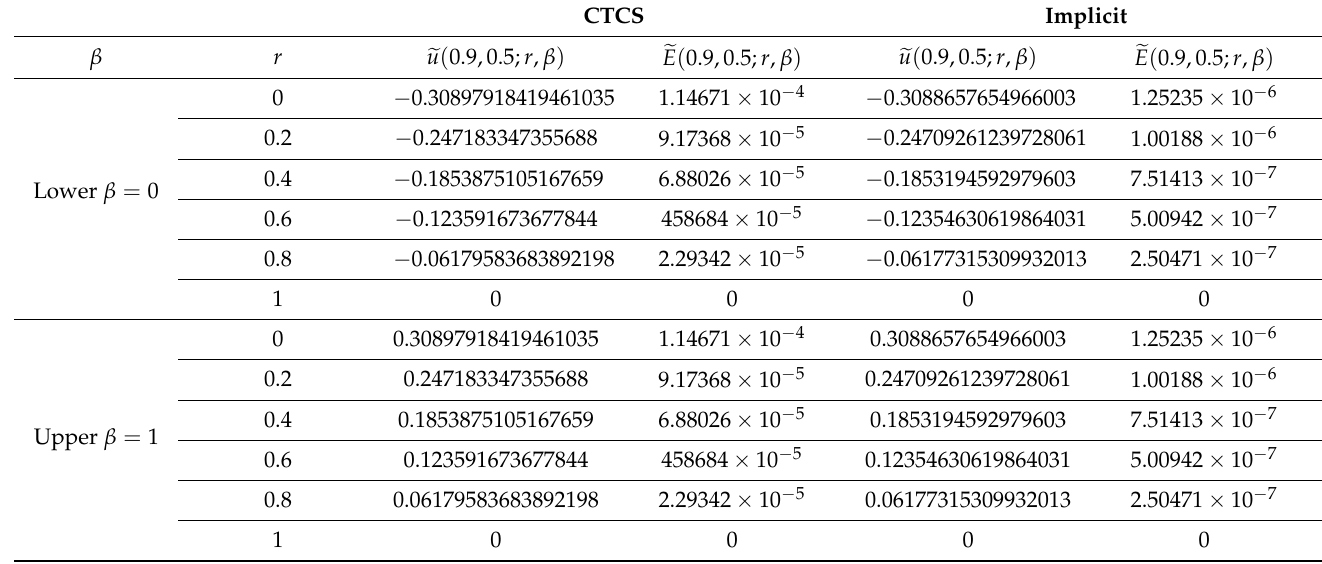
Table 1. Numerical solution of Equation (31) by CTCS and implicit at t = 0.05 and x = 0.9 for r , β ∈ [ 0,1 ] .